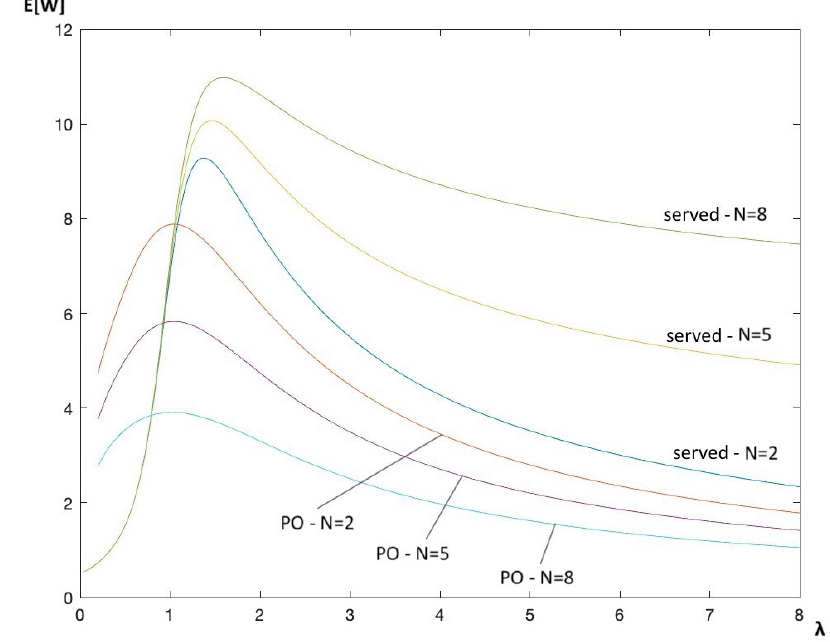
Figure 5. Mean waiting time of served and pushed-out customers for different values of 𝑁 .